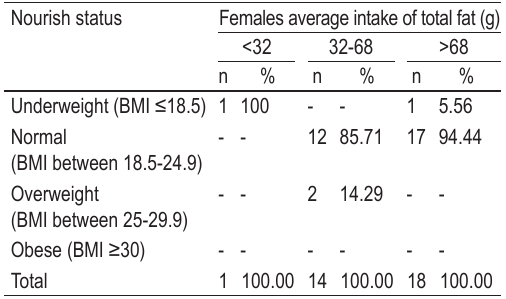
TABLE 6. Average total fat intake of females compared with recommendation